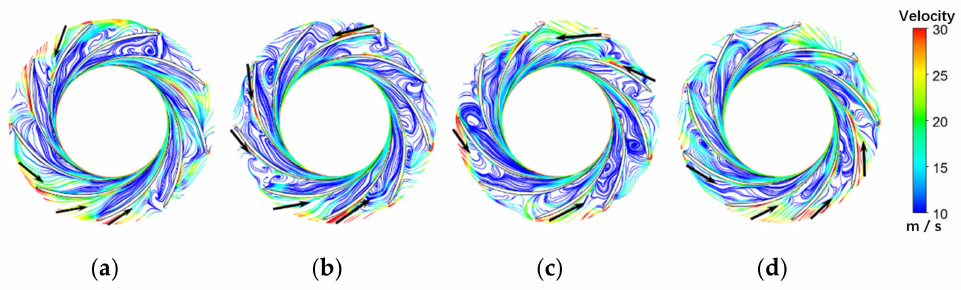
Figure 17. Streamlines in the runner passages at typical times in Case1. ( a ) t = 47 s; ( b ) t = 54 s; ( c ) t = 63 s; ( d ) t = 71